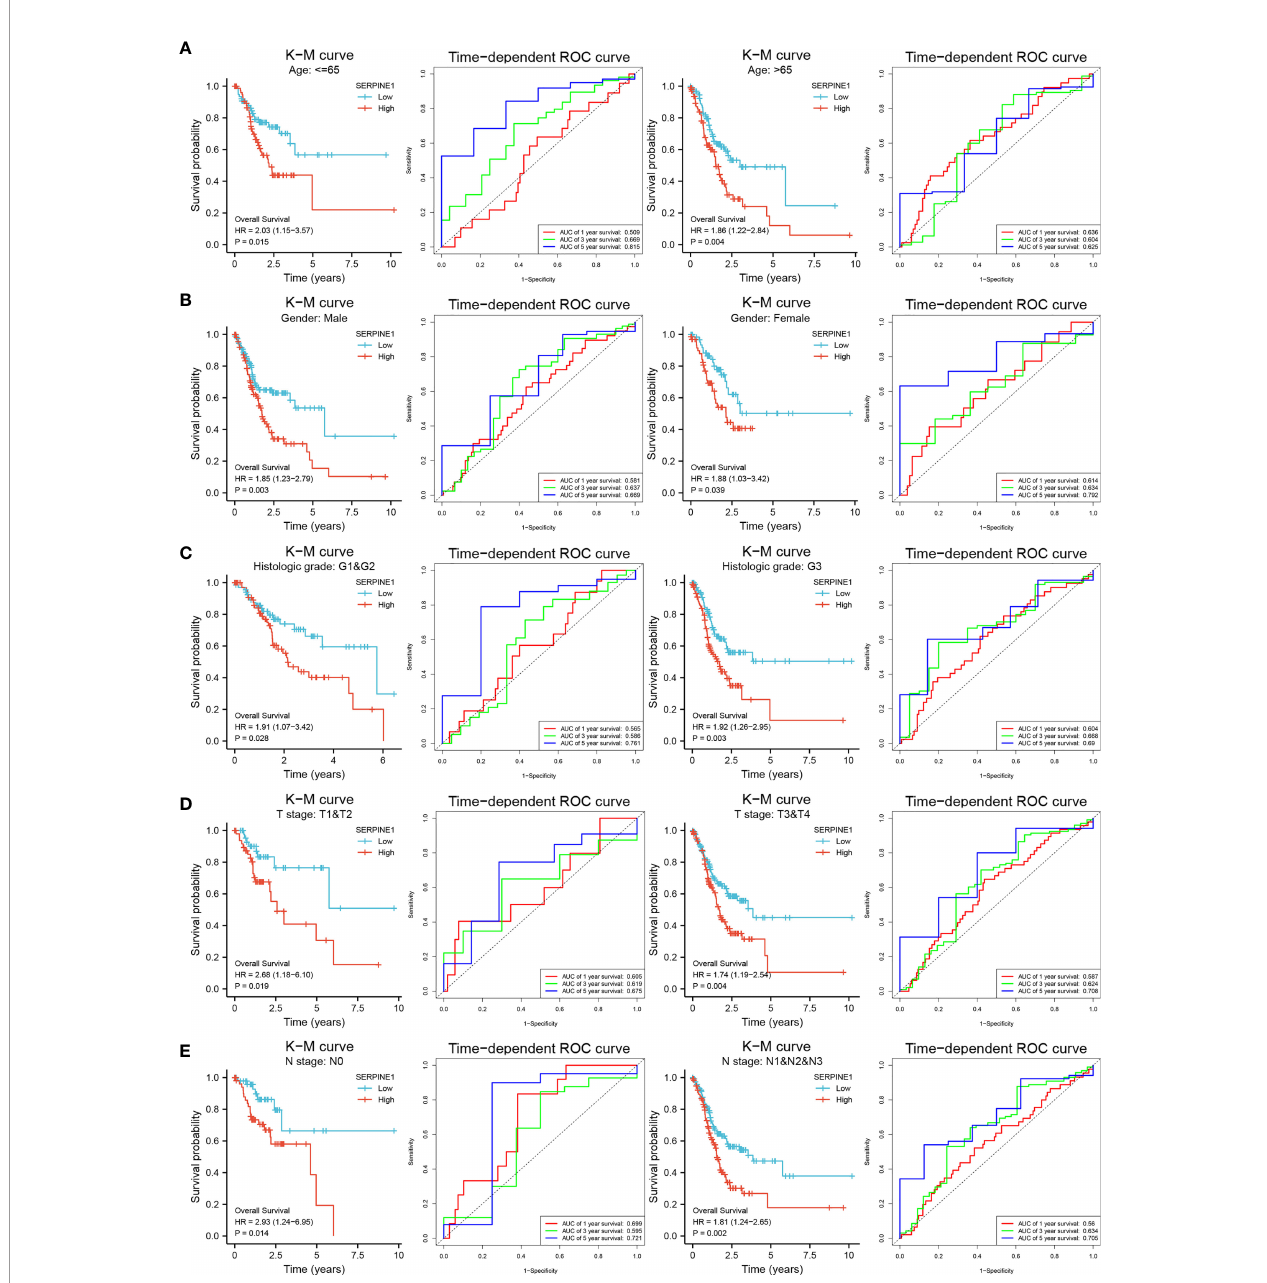
FIGURE 7 | Strati fi cation analysis of SERPINE1 biomarker. K-M curves and time-dependent ROC curves illustrate the prognostic value of the SERPINE1 biomarker based on the strati fi cation of different clinical features. (A) Age. (B) Gender. (C) Histologic grade. (D) T stage. (E) N